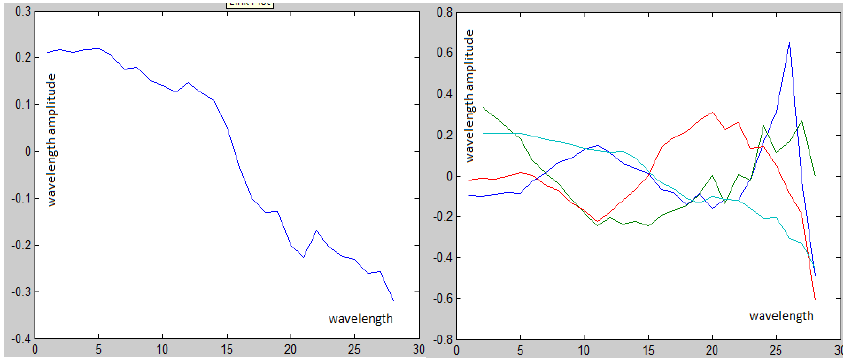
Figure 22. Left: The target’s spectrum. Right: The principal components of the background’s spectra. The spectra was taken from the “city” image (Figure 5).